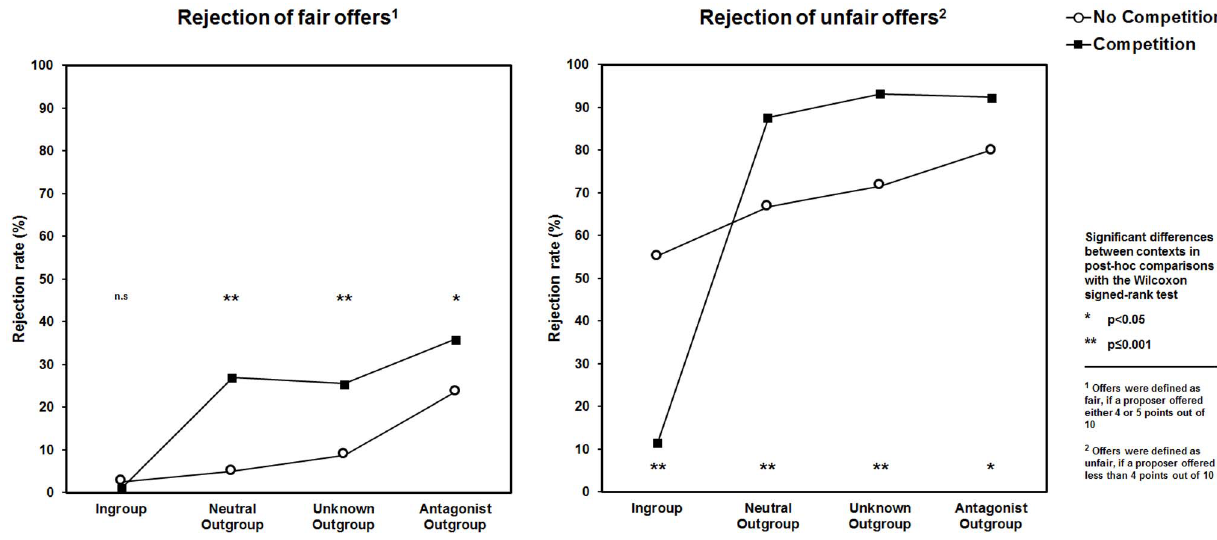
Figure 2. Rejection rates varied with the type of proposal, group membership and experimental context. (A) Rejection rates of fair offers by ingroup and outgroup members. Even in case of fair bargaining rejection rate increased with social distance to outgroup (outgroup hostility) and during the competition context. (B) Rejection rates of unfair offers by in- and outgroup members. Again, outgroup hostility increased with social distance and competition. Except for offers made by ingroup members, in the competitive context the rejection rate of unfair offers decreased drastically.